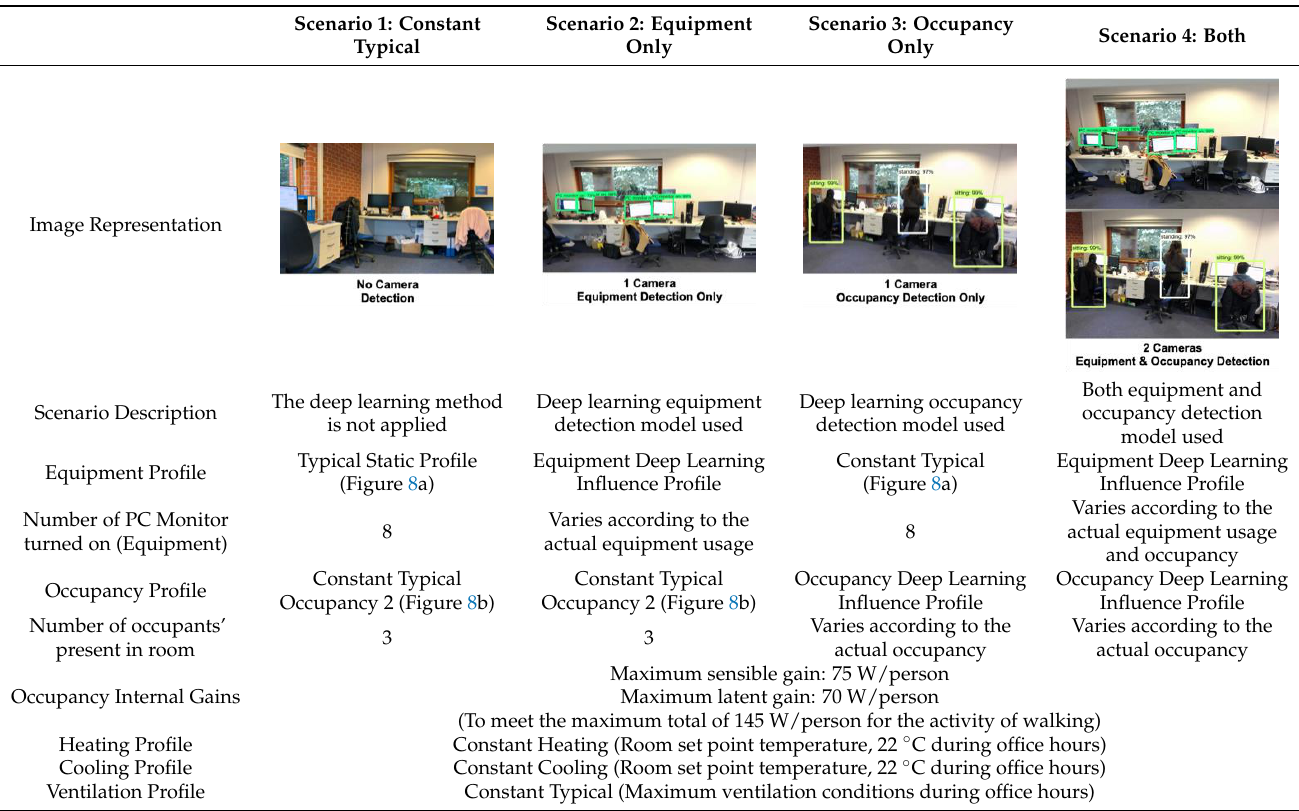
Table 4. Summary of the test scenario cases with the assigned building, equipment and occupancy building energy simulation modelling profiles and conditions.